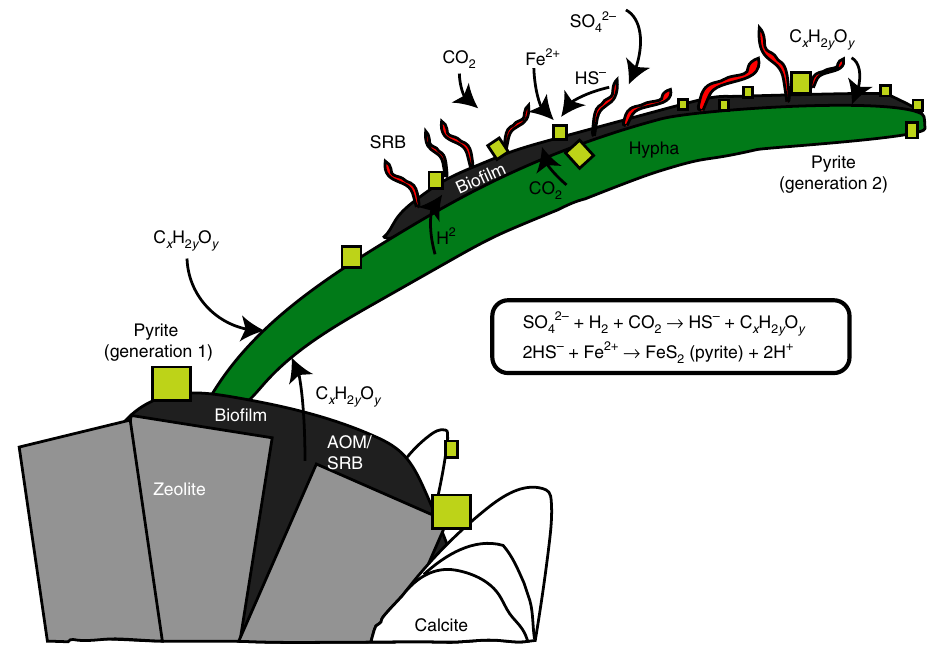
Fig. 8 Conceptual model of coexistence and growth of fungi and sulfur reducing bacteria deep in crystalline bedrock. Growth of hypha starts at the bio fi lm on the zeolite surface, where sulfate reduction by sulfate-reducing bacteria (SRB) and anaerobic oxidation of methane (AOM) has led to oversaturation and precipitation of older calcite and pyrite. The bio fi lm provides organic carbon (C x H 2 y O y ) for the fungi to build biomass. The growing hypha metabolizes dissolved organic carbon both from the water and from the syntrophic SRB, which in turn thrive from the H 2 produced by the fungi. The SRB reduce sulfate (SO 4 2 − ) dissolved in the water autotrophically and produce HS − which reacts with dissolved Fe 2+ to form pyrite (now present on the hypha). The SRB use CO 2 from both the fungal metabolism and dissolved CO 2 in the water as carbon